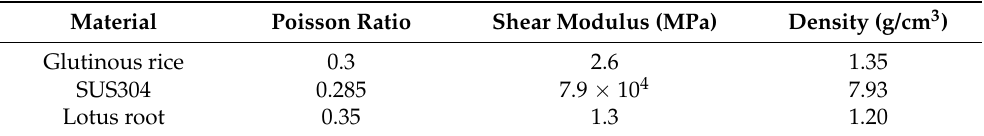
Table 1. Mechanical properties of materials.